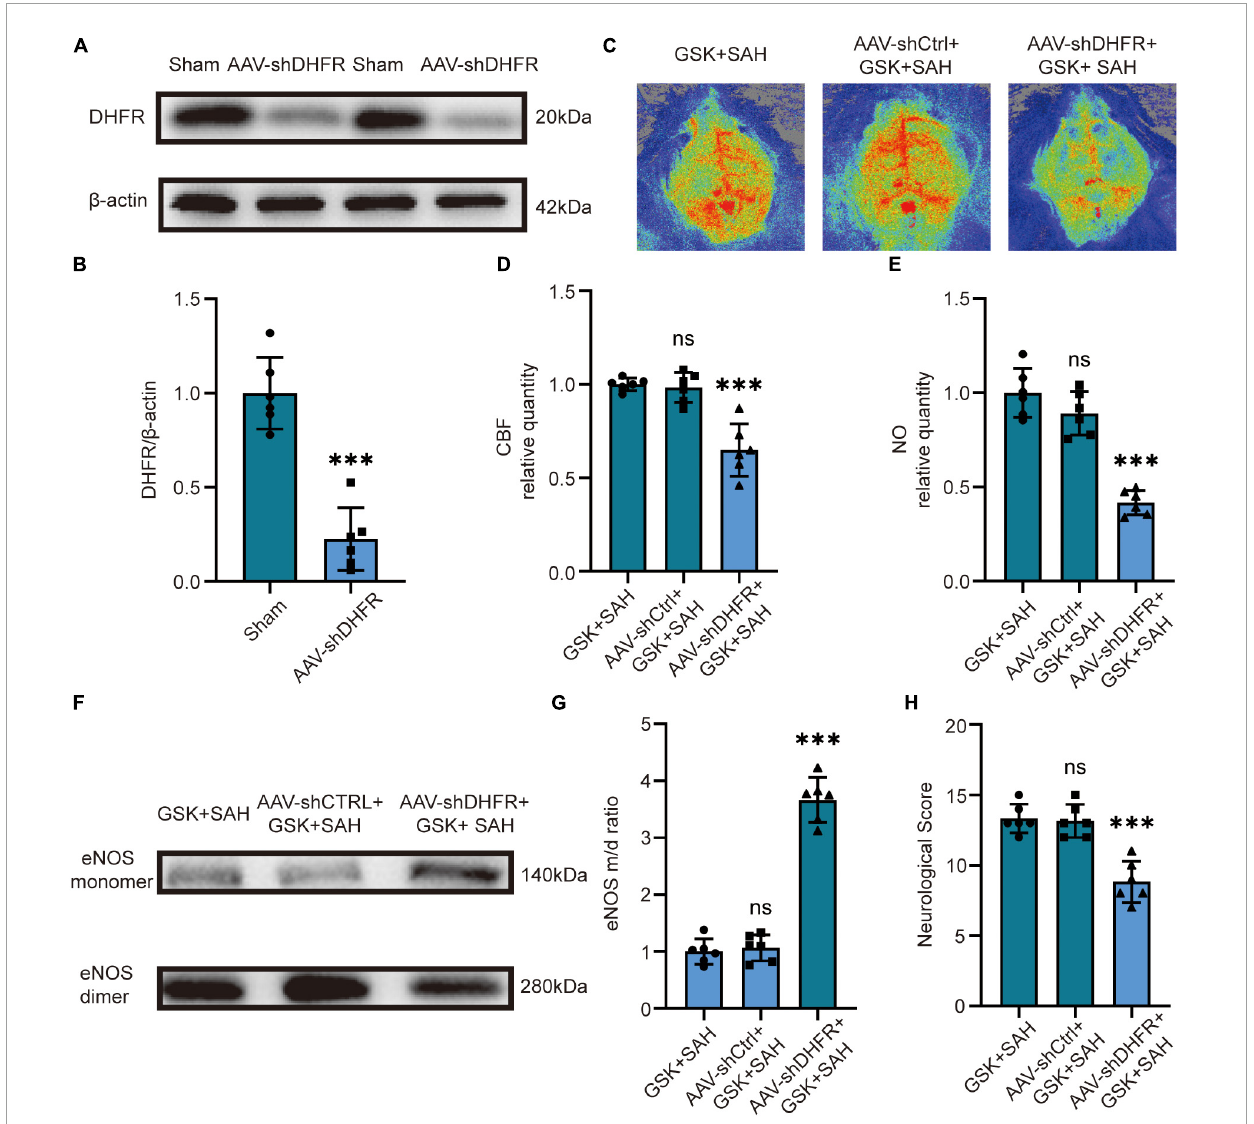
FIGURE5 In vivo , knockdown of DHFR partially counteracted the effect of NOX2 inhibitors on relieving acute cerebral ischemia in SAH. (A,B) Representative Western blot images and quantitative analysis of endothelial DHFR expression by ImageJ. Data are shown as mean ± SD ( n = 6 mice each group, ∗∗∗ p < 0.001). (C) Representative LSCI images among different experimental groups. (D) Quantitative analysis of CBF among different experimental groups. Data are shown as mean ± SD ( n = 6 mice each group, ∗∗∗ p < 0.001, ns: no statistically significant difference). (E) NO content in extracted endothelial cells among different experimental groups. Data are shown as mean ± SD ( n = 6 mice each group, ∗∗∗ p < 0.001, ns: no statistically significant difference). (F,G) Representative Western blot images and quantitative analysis of eNOS monomer and eNOS dimer expression by ImageJ. Data are shown as mean ± SD ( n = 6 mice each group, ∗∗∗ p < 0.001). (H) Modified Garcia Score among different experimental groups. Data are shown as mean ± SD ( n = 6 mice each group, ∗∗∗ p < 0.001, ns: no statistically significant